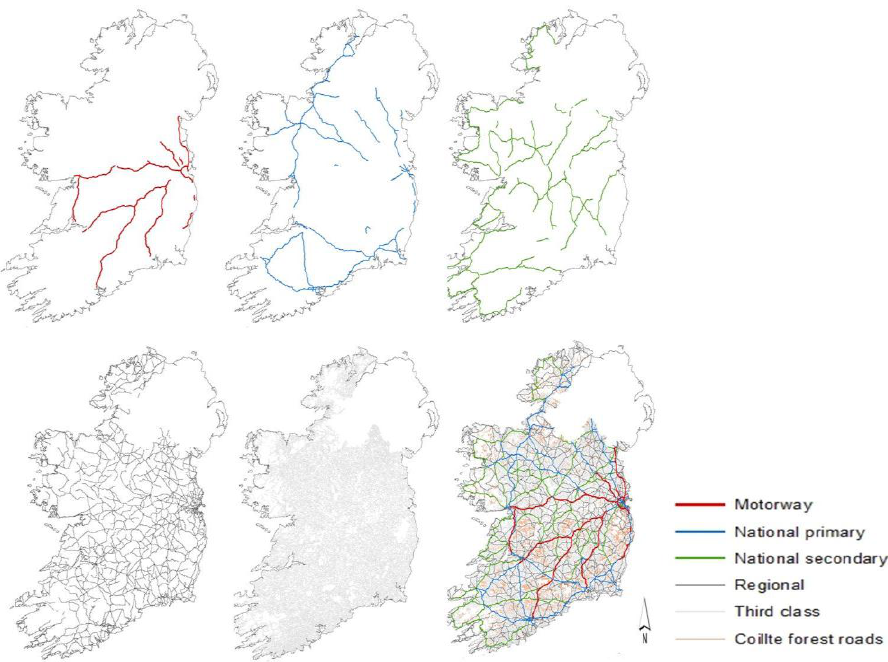
Figure 1. Geographic information systems (GIS) map of Ireland’s road network.